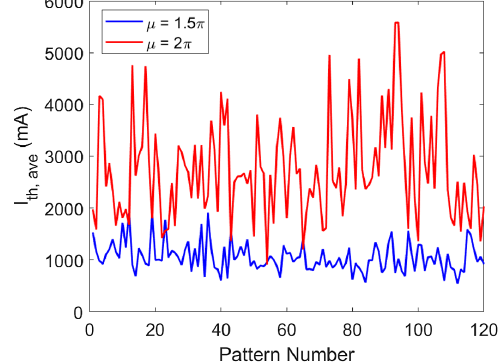
FIG. 10. Average threshold current 120 SP patterns with different phase advances with 10 T rf bunch spacing.